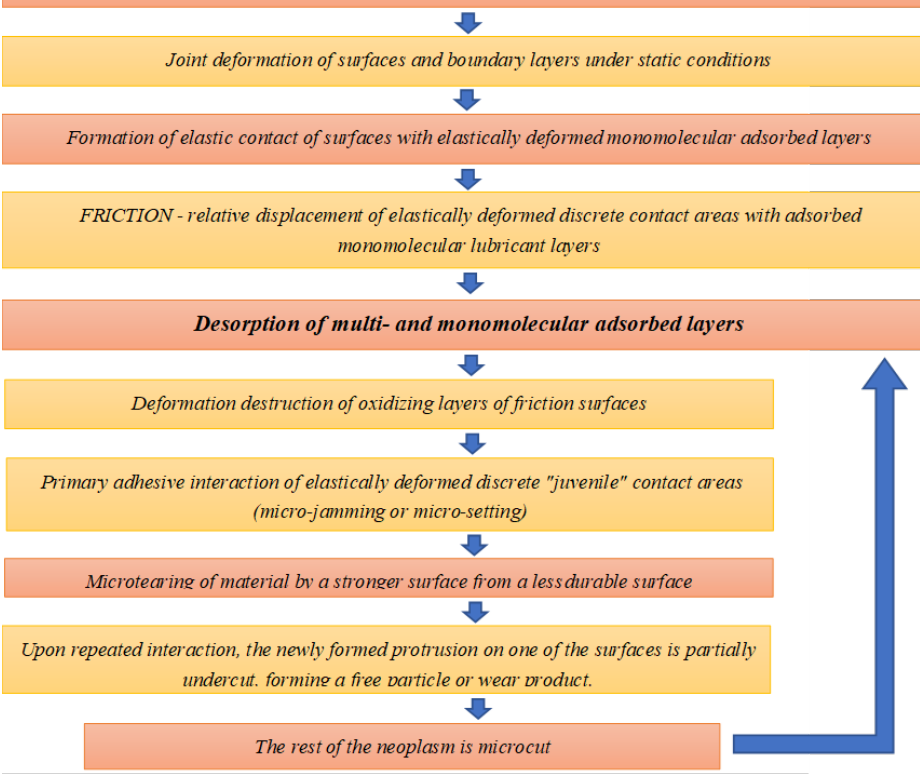
Fig. 4 Process of the destruction of lubricant layers and oxidative layers on